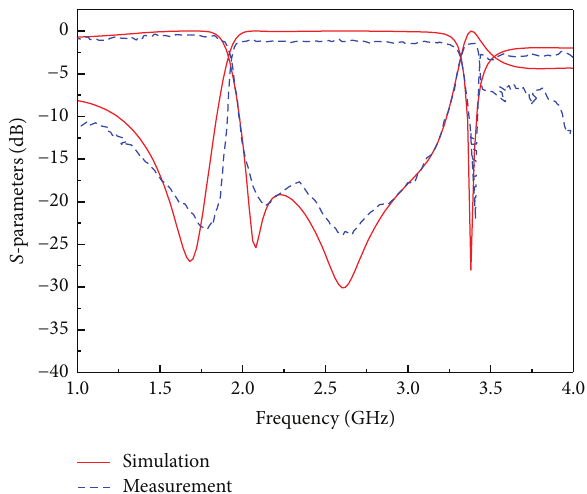
Figure 5: Measured and simulated responses of the wide-band